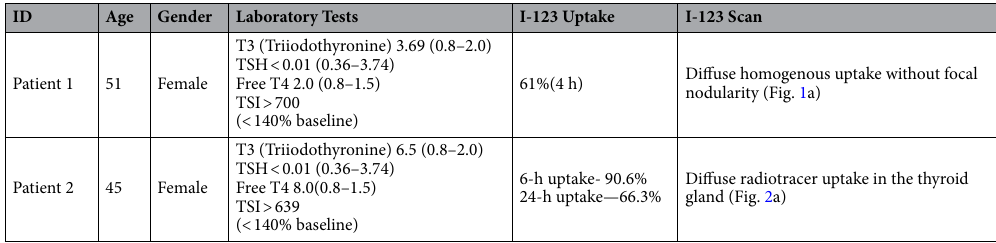
Table 2. Characteristics of Patients with Graves Disease. TSI thyroid stimulating immunoglobulins.